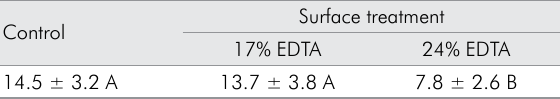
Table 1. Mean values and standard deviation of bond strength (MPa) for self-adhesive resin cement RelyX™ U200.